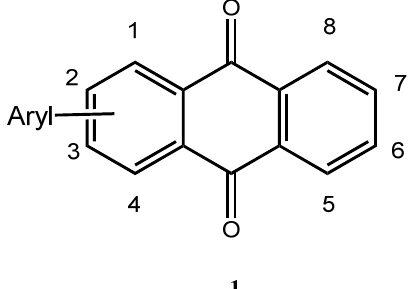
Figure 1. General Structure of arylated